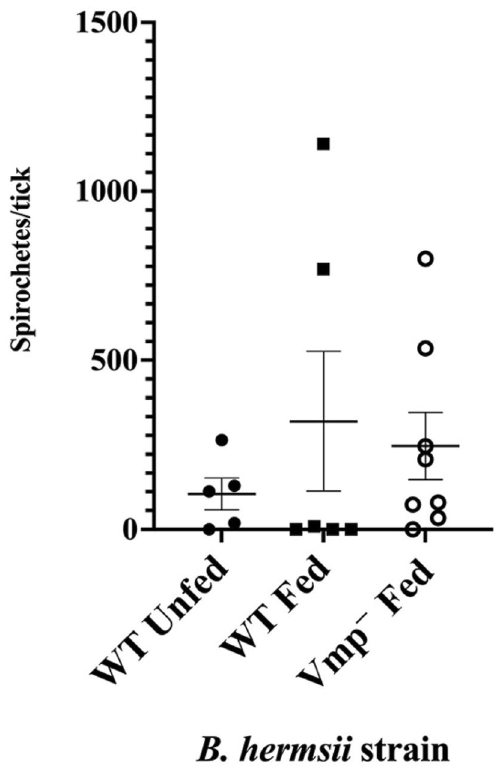
Figure 5. B. hermsii densities within the tick decrease following acquisition. Ticks that had acquired the infection by feeding through an artificial membrane were sampled after molting (WT Unfed), or after a subsequent bloodmeal on uninfected SCID mice (WT Fed and Vmp – Fed). Individual ticks were crushed and spirochete densities determined by colony count on solid medium. Each symbol represents B. hermsii densities within an individual tick. No significant difference was observed between WT Fed and the other two samples, as calculated by an unpaired, 2-tailed T-test. Results from two independent feeding experiments are shown. Bars represent the mean ± the standard error of the